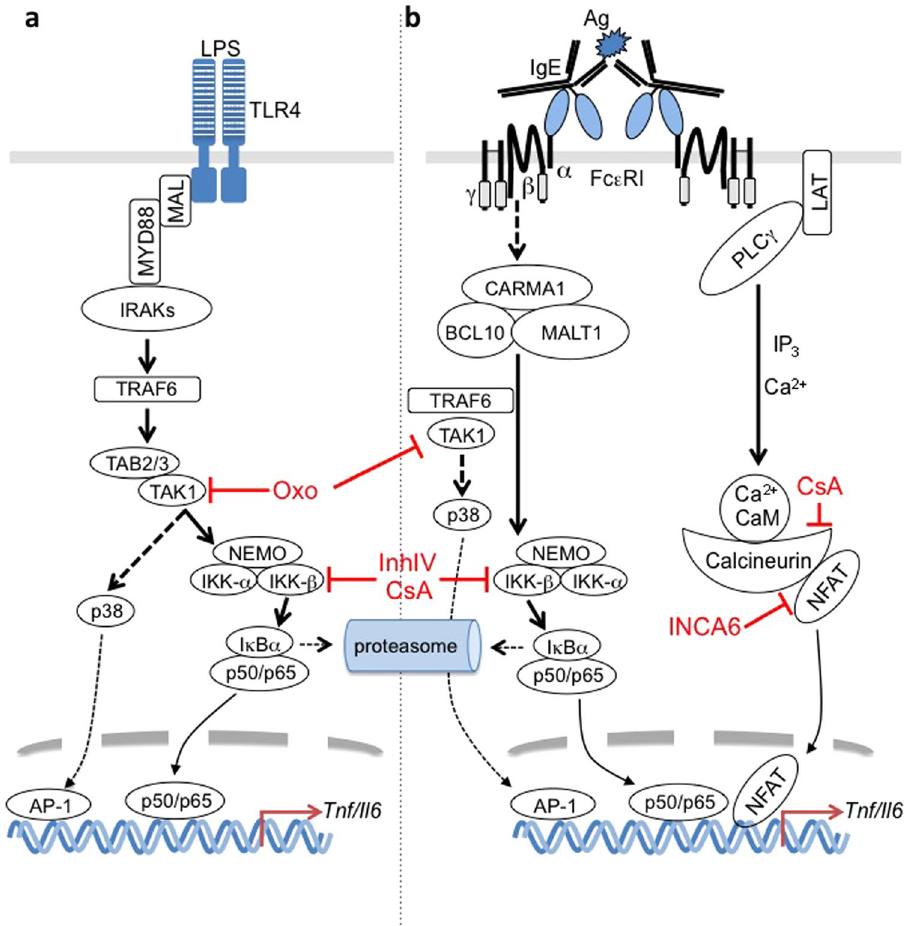
Figure 7. Differences and commonalities in TLR4- and Fc ε RI-activated production of proinflammatory cytokines. ( a ) LPS-induced stimulation of TLR4 in MCs results in activation of the MYD88 pathway. The E3 ligase TRAF6 mediates the activation of the Ser/Thr kinase TAK1, which allows for bifurcation of the signal into the NF κ B and MAPK pathways leading to transcription of proinflammatory genes. This is suppressed by inhibition of TAK1 (by Oxo) and IKK- β (by InhIV; CsA inhibits calcineurin, indirectly contributing to suppression of IKK- β 31, 33 ). ( b ) Ag-induced crosslinking of the IgE-bound Fc ε RI leads to NF κ B activation mediated by the CARMA1/BCL10/MALT1 complex as well as TRAF6 and TAK1 23, 52 . In contrast to TLR4 signalling, Fc ε RI triggering leads to PLC γ /IP 3 -controlled store-operated Ca 2 + influx allowing for dephosphorylation/activation of NFAT by Ca 2 + /CaM-activated calcineurin. Whereas CsA directly and indirectly inhibits calcineurin and IKK- β , respectively, INCA6 selectively blocks the interaction of calcineurin and NFAT 30